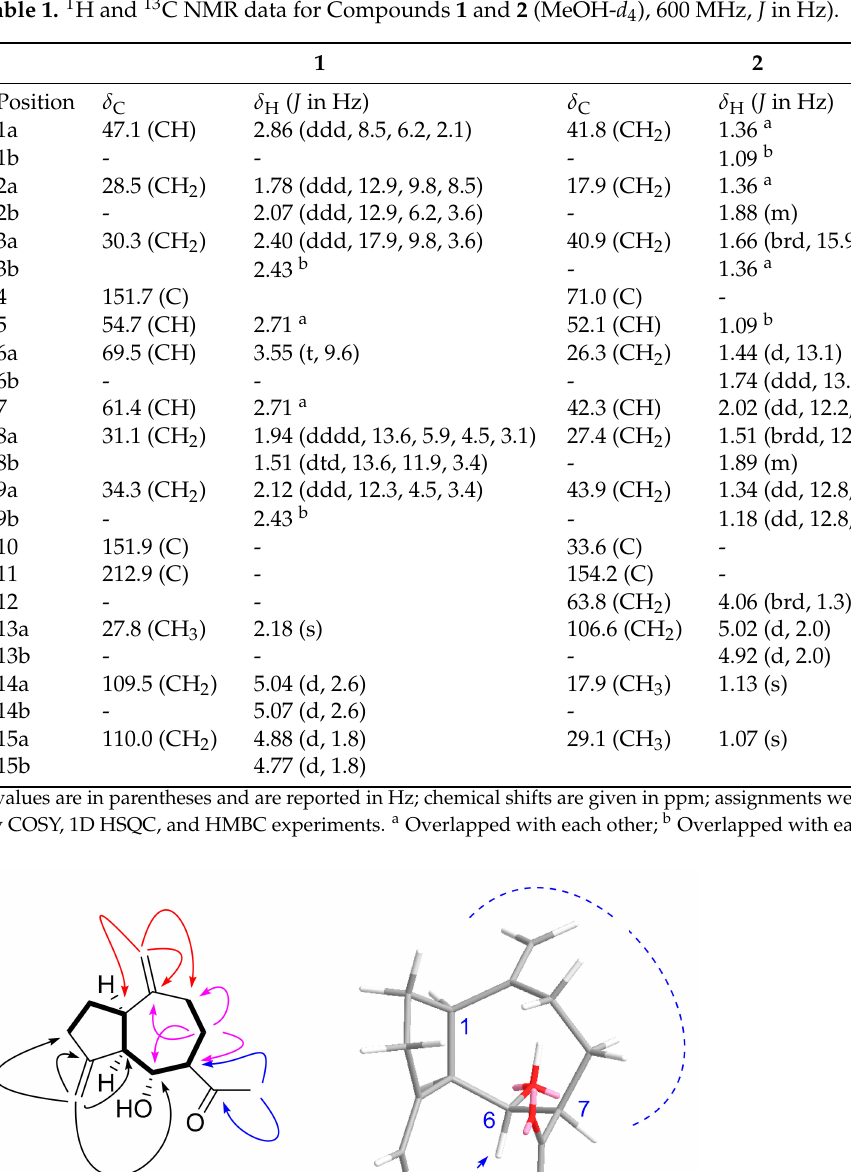
Figure 4. Comparison of the calculated ECD spectrum for (4 S , 5 S , 6 S , 10 S )- 1 at B3LYP/6-31G(d) level with the experimental spectrum of 1 in MeOH. σ = 0.3 eV, shift = − 10 nm. Compound 2 , a colorless needle crystal, [ α ] 23.2 D 12.2 ± 0.31 (c 0.15, MeOH), had the molecular formula of C 15 H 26 O 2 ( ∆ mmu 0.20), as deduced from the HRESIMS (Calcd. for C 15 H 26 O 2 Na, m / z 261.1826), 13 C NMR and HSQC data. The 1 H NMR (MeOH- d 4 ) data for 2 (shown in Table 1) showed two singlet methyls ( δ H 1.13, 1.07) and a terminal olefinic pro- ton ( δ H 5.02, 4.91). The 13 C NMR (MeOH- d 4 ) data for 2 (shown in Table 1) suggested 15 carbons including two methyls ( δ C 29.1 and 17.9), eight methylenes including an oxymeth- ylene ( δ C 63.8) and a terminal olefin ( δ C 106.6), two methines ( δ C 52.1 and 42.3) and three quaternary carbons including one oxy-quaternary carbon ( δ C 71.0) and one alkenyl ( δ C 154.2). The aforementioned NMR data of 2 were similar to those of 4 α -hydroxy-4 β -me- thyldihydrocostol ( 10 ) [21], an eudesmane sesquiterpene; however, they differed in that C-2, C-3, C-4 and C-5 of Compound 2 were shifted to high field by 1.8, 1.8, 0.5 and 2.3 ppm, respectively, and C-1 and C-15 were shifted to low field by 1.0, and 7.9 ppm, respec- tively. The above data suggest that Compound 2 may be an epimer of Compound 10 . Furthermore, HMBC correlations of methyl ( δ H 1.07, Me-15) to C-3/C-4/C-5, methyl ( δ H 1.13, Me-14) to C-1/C-5/C-9/C-10 and methylene ( δ H 4.06, CH 2 -13) to C-7/C-11/C-12 (shown in Figure 5), as well as other key HMBC related signals, confirmed the planar structure of Compound 2 (shown in Figure 5). The relative configuration of 2 was estab- lished using the ROESY spectrum. The ROESY correlation of H-5 with Me-15/H-7